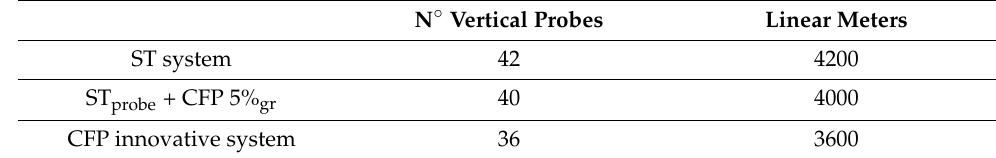
Table 7. Dimensioning of the geothermal field (probes of 100 m